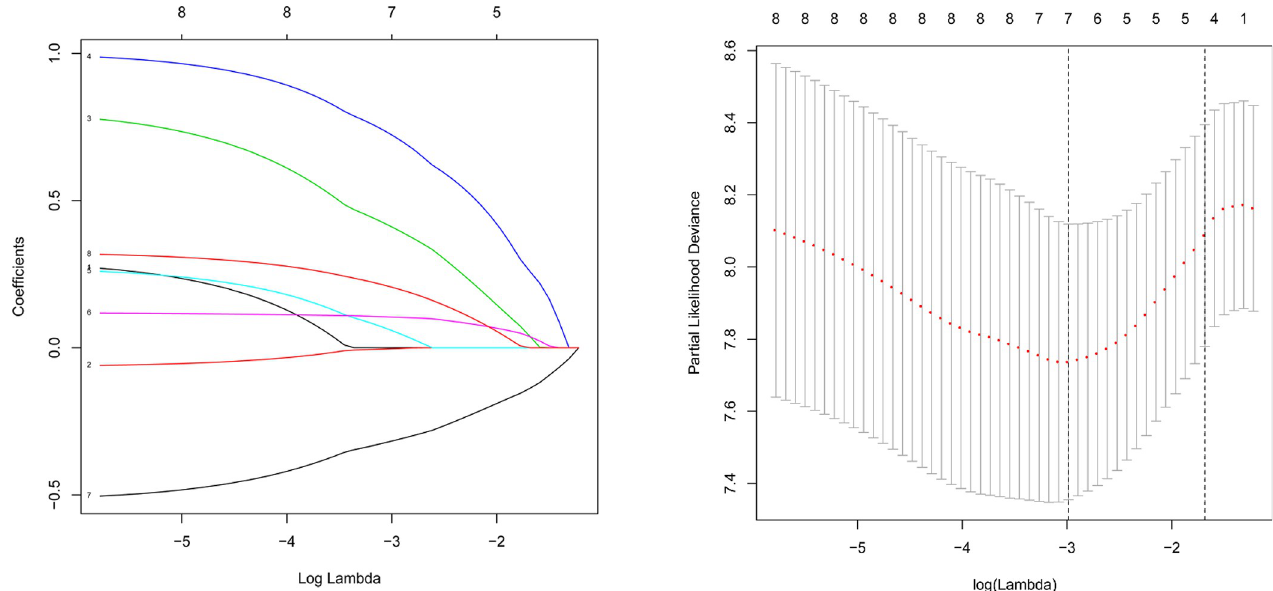
Fig 4. Lasso-penalized Cox regression analysis of 9 DEmRNAs. The coefficient values at varying levels of penalty (A). Each curve represents an mRNA. Ten- fold cross-validation was used to calculate best lambda which leads to minimum mean cross-validated error (B). Red dots represent partial likelihood deviance; solid vertical lines indicate their corresponding 95% CI; the left dotted vertical line is the value of lambda that gives minimum cvm, named lambda. min; the right dotted vertical line is the largest value such that error is within 1 standard error of the minimum, named lambda. 1se.